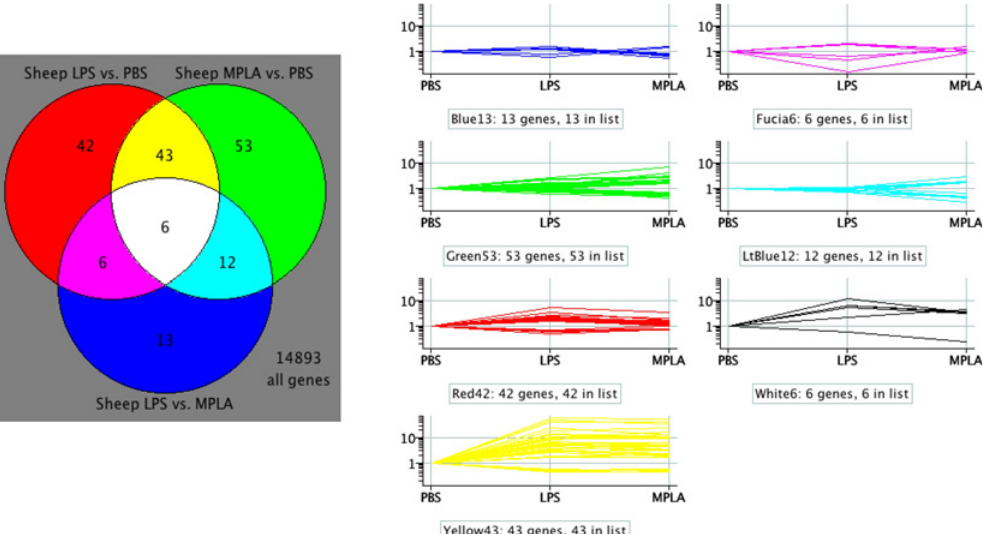
Fig 4. Differentially expressed sheep genes in at least one of three comparisons ( > 1.5-fold, paired t-test p-values < 0.05, 175 probes) are displayed as normalized to the PBS sample within each individual. Line graph colors correspond to the colors in the Venn diagram (white = black).